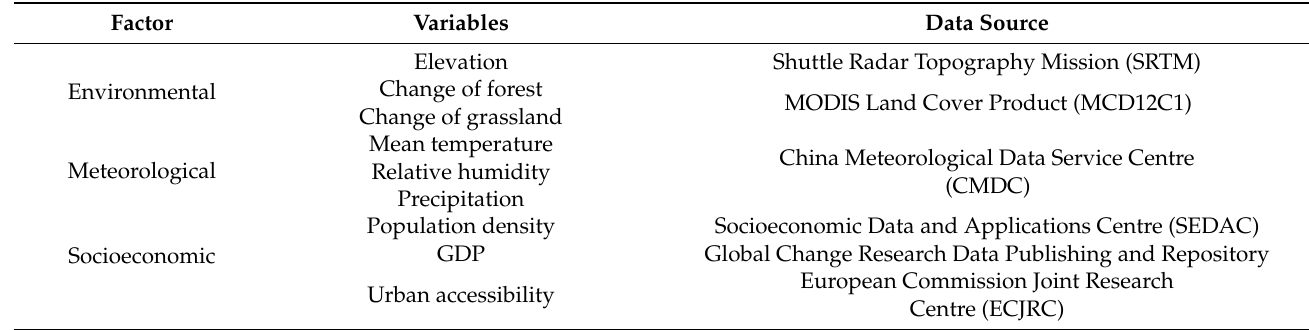
Table 1. The spatial predictors adopted in this